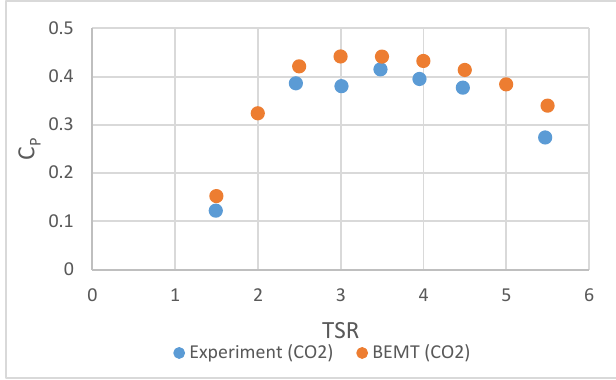
Figure 5. C T comparison between BEMT and experiment for the 0.5